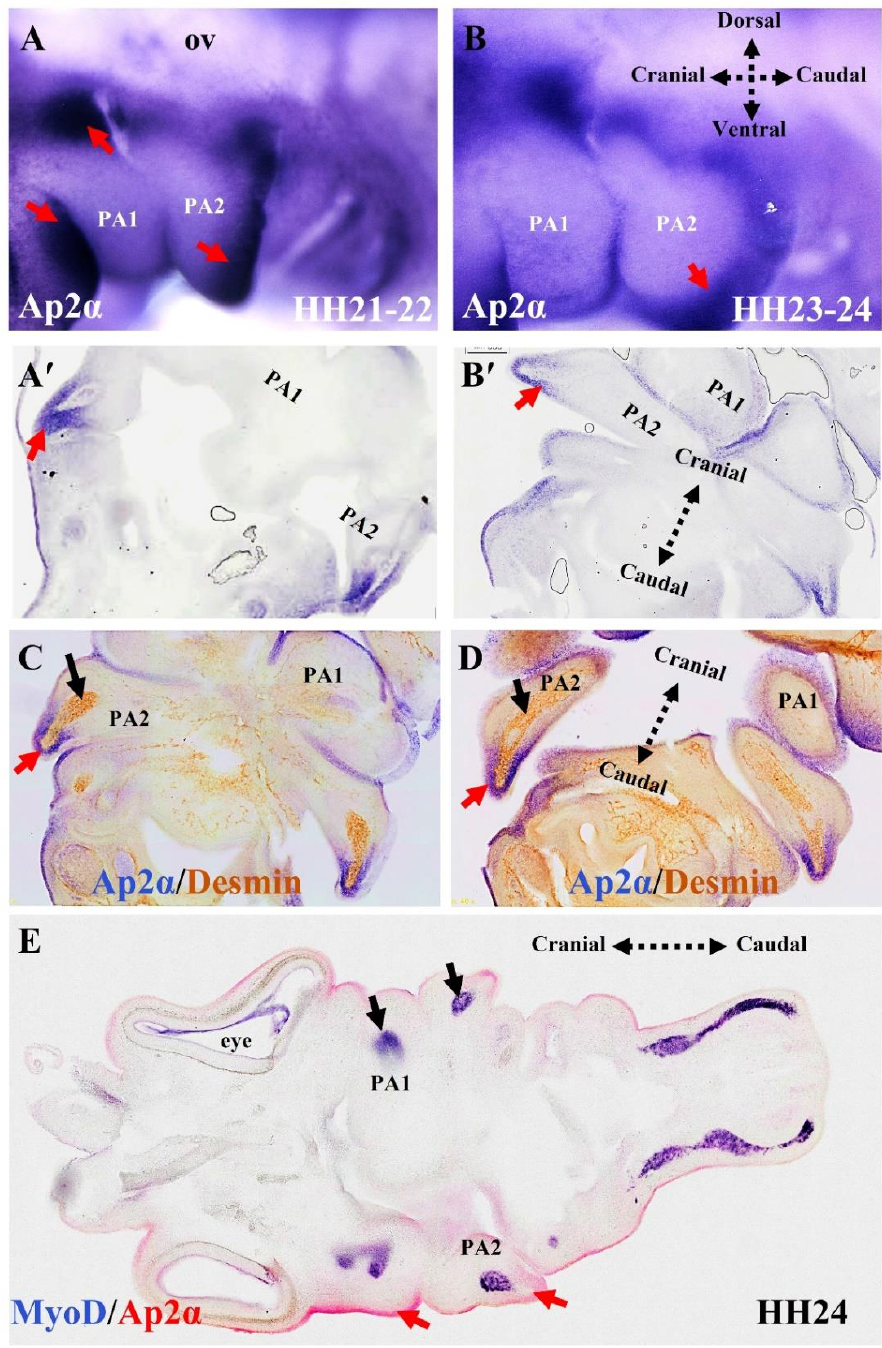
Figure 4. Ap2α marks ectomesenchymal neural crest cells in the first and second pharyngeal arches. ( A , B ) Analysis of Ap2α expression using whole-mount in situ hybridization. Lateral views of stages HH21-22 and HH23-24. ( A ’ , B ’ ) Adjacent vibratome frontal sections of the chicken embryos in ( A ) and ( B ) at the level of first and second pharyngeal arches. ( C , D ) Immunostaining for Desmin on the same frontal sections as in ( A ’ , B ’ ) after whole-mount in situ hybridization. The mesodermal core was visualized with Desmin antibody (black arrows). ( E ) The frontal section shows double whole-mount in situ hybridization for MyoD (blue) and Ap2α (red). Note that Ap2α marks the ectomesnchymal neural crest (red arrows) and MyoD marks the mesodermal core of the pharyngeal arches (black arrows). PA1, first pharyngeal arch; PA2, second pharyngeal arch; ov, otic vesicle.